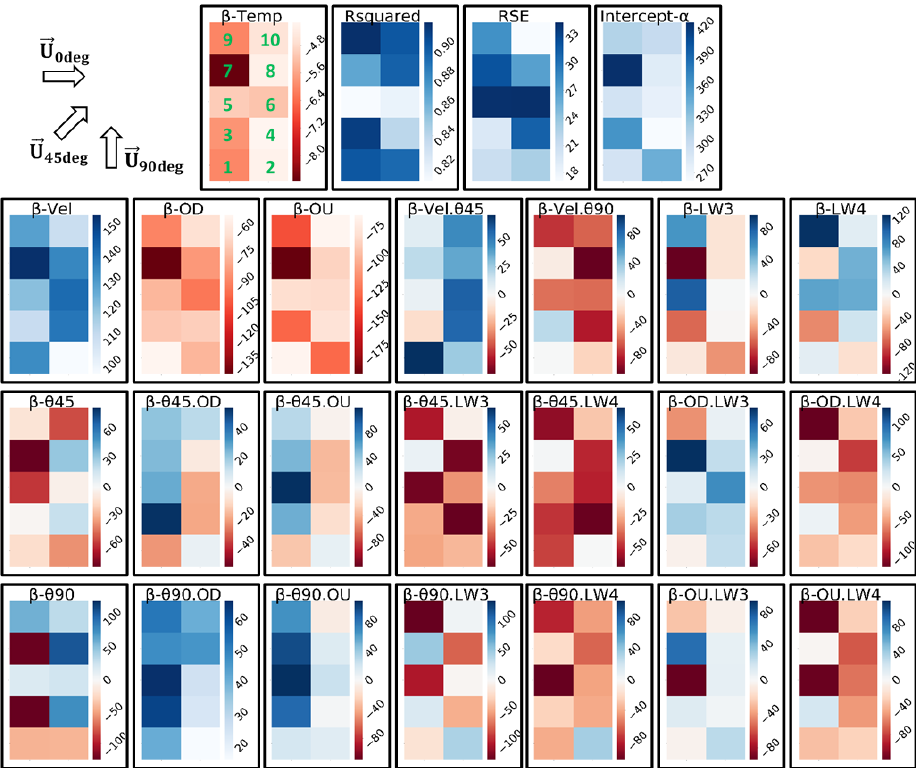
Figure 10. RSE, R 2 and coefficients of the AER Box . i of Equation (12) corresponding to the forced convection